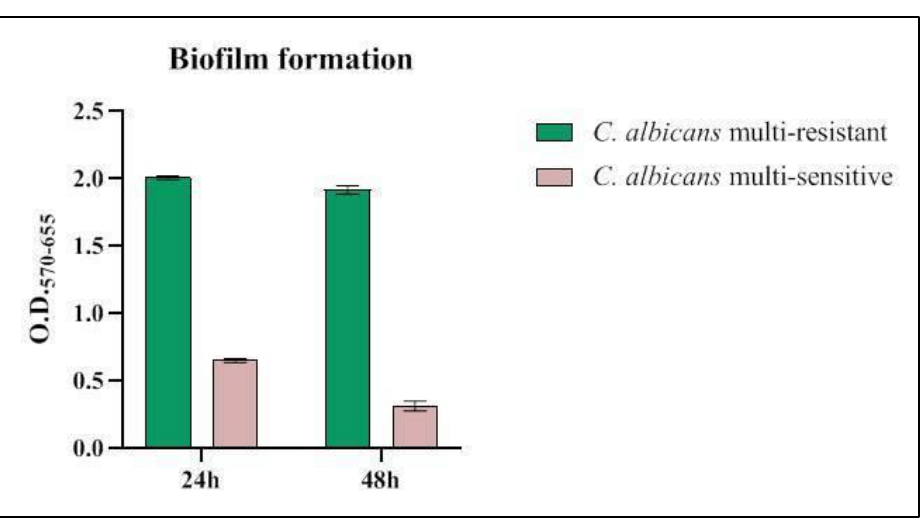
Figure 2. Comparison between C. albicans from the first and the last swab. ( A ) Genomic fingerprinting of C. albicans from the first and the last swabs obtained by RAPD-PCR. ( B – G ) Gram staining of C. albicans from the last ( B ) and first swabs ( C ) at 40× magnification. ( D , E ) Gram staining of C. albicans from last swab at 100× magnification. ( F , G ) Gram staining of C. albicans from first swab at 100× magnification. Note the hyphal pattern in the first swab ( C , F , G ) and the yeast cells in the last swab ( B , D , E ).